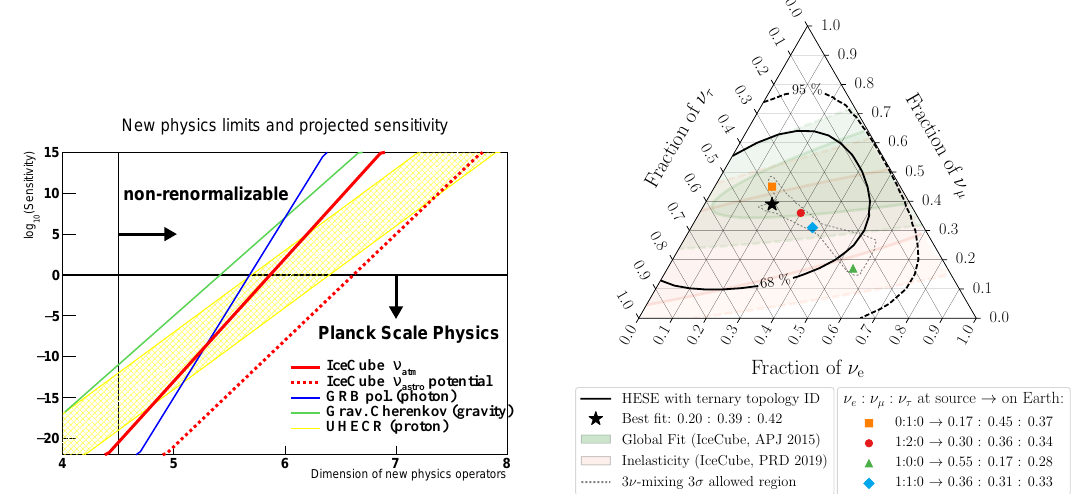
Figure 3. Left, the LV sensitivities of different systems. The sensitivity is normalized with the Planck energy ( E P = 1.22 10 19 GeV) assuming LV arises from Planck-scale physics. This means that the natural scale of a dimension-five × LV operator is 1/ E P , a dimension-six LV operator is 1/ E 2 , and so on, and the sensitivity is normalized, so that these numbers P appear to have unity. Lines are gravitational Cherenkov emission [67,68], GRB vacuum birefringence [69], UHECRs [12], atmospheric neutrino oscillations [63], and the expected sensitivity from the high-energy astrophysical neutrino flavors. Figure is adapted from [66]. Right, HESE flavor ratio ( ν e : ν µ : ν τ ) measurement by IceCube. Each corner represents electron, muon, and tau neutrino dominant state. The standard scenarios (dotted line area) give roughly ( ν e : ν µ : ν τ ) (1:1:1) on the ∼ Earth, regardless of the assumption of the flavor ratio at the source. This means the expected flavor ratio on the Earth is always around the center of this plot, in standard assumptions. On the other hand, current data contours enclose a large area, so different standard scenarios cannot be distinguished. Figure is adapted from